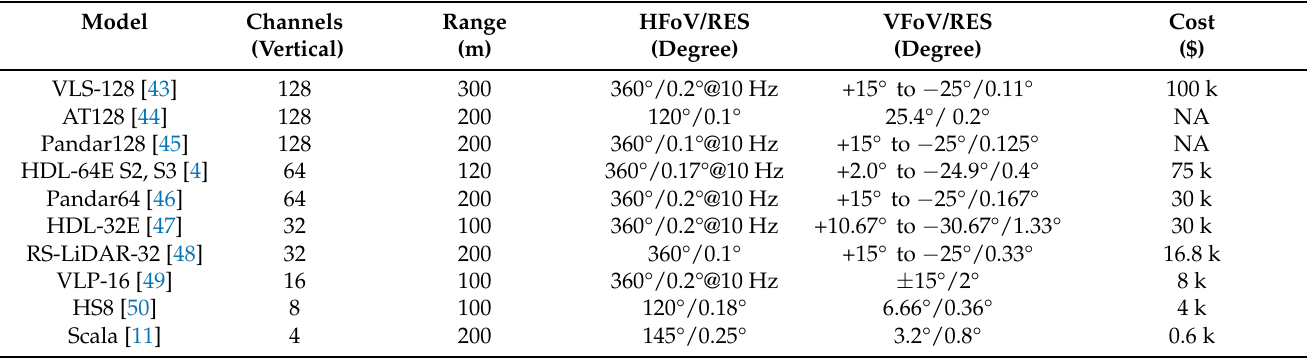
Table 2. Comparison of some LiDAR sensors. Channels show the number of laser beams of the LiDAR sensor vertically. Range indicates the maximum distance to objects at which a LiDAR can detect. HFoV/RES and VFoV/RES decode the horizontal and vertical field of view and angular resolution, respectively. There are a number of LiDARs whose resolution depends on